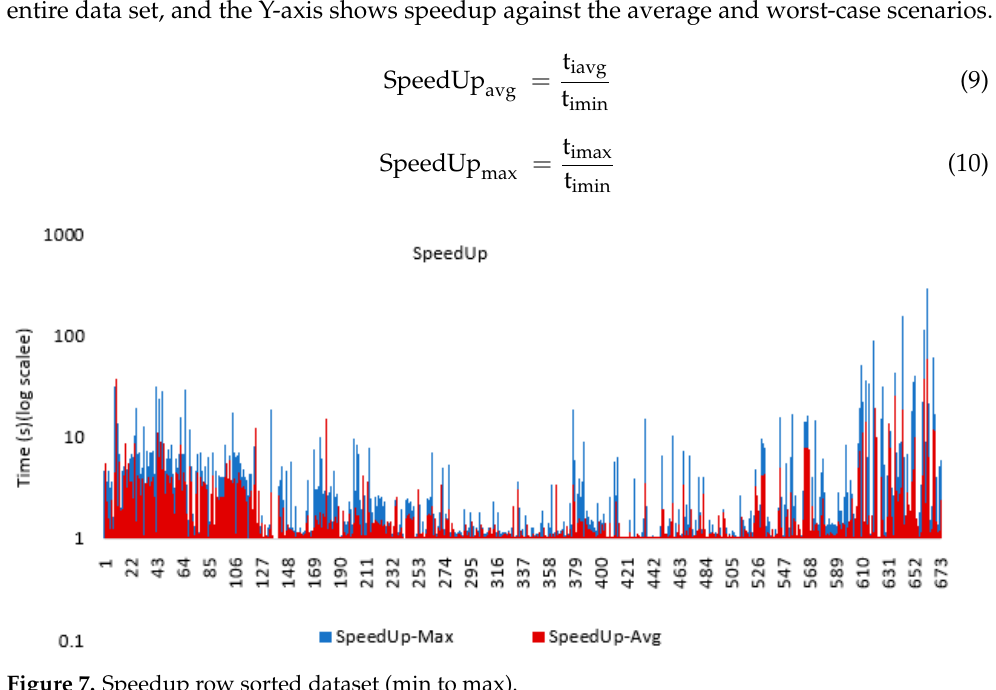
Figure 6. Execution time comparison of CSR and BCSR (with and without format conversion time).